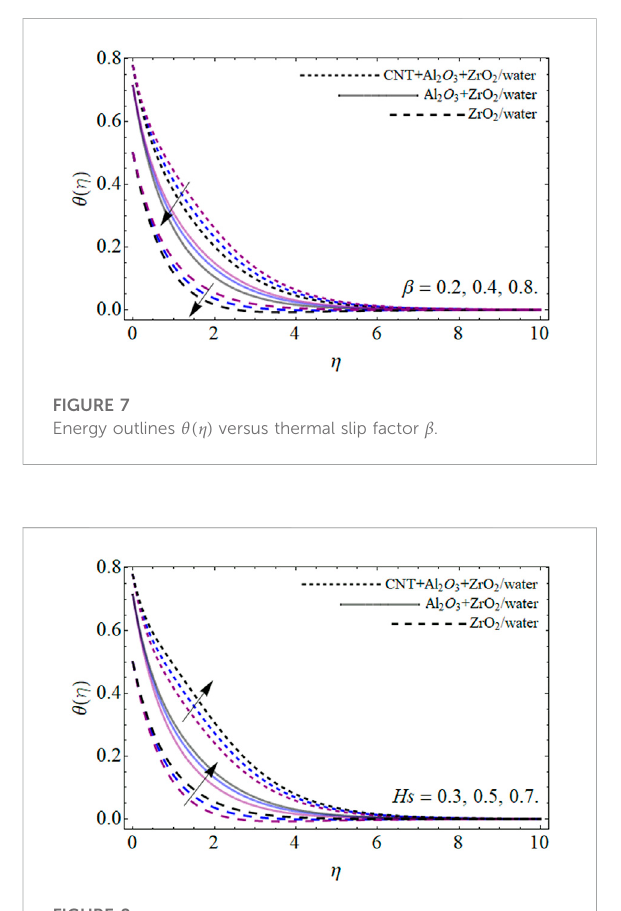
FIGURE 8 Energy outlines θ ( η ) versus heat source Hs .